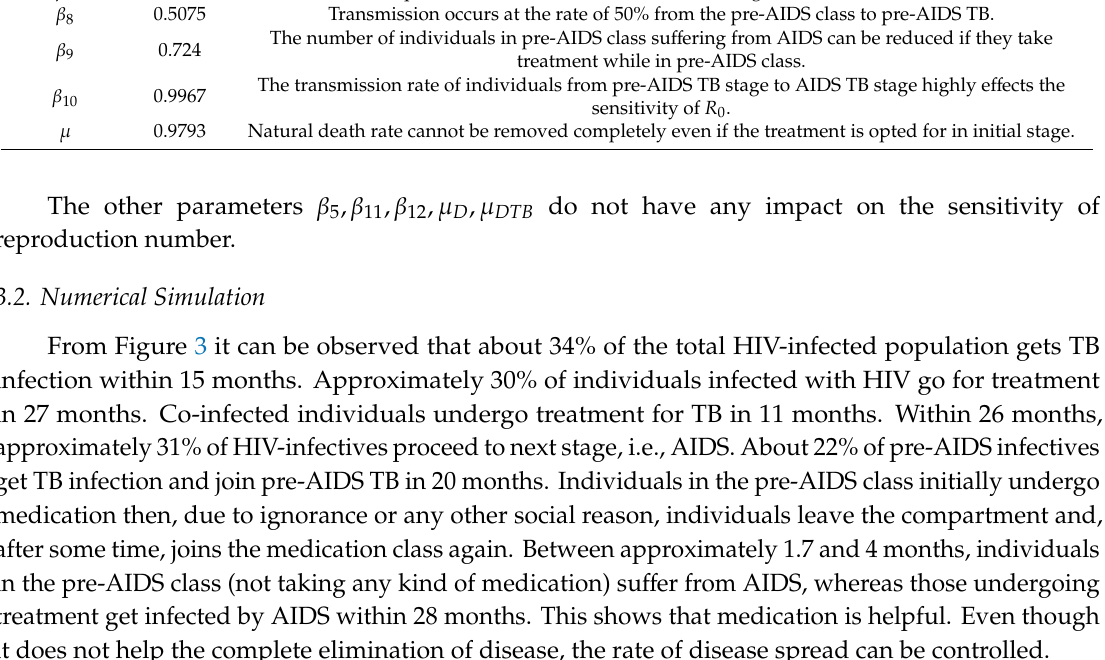
Table 2. effect of Parameters on Sensitivity.